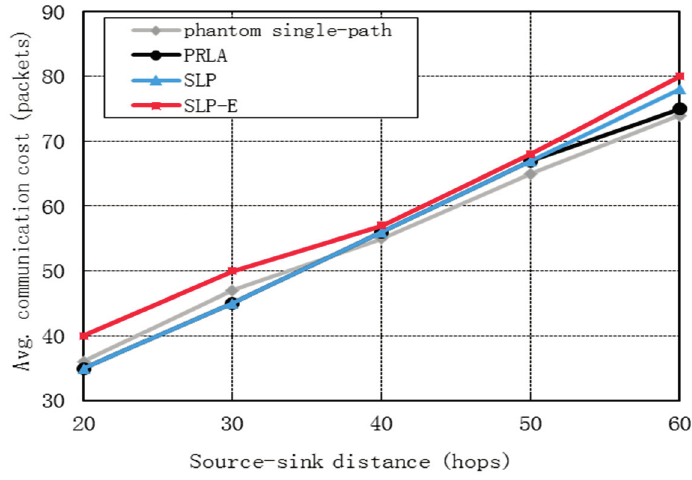
Figure 5. Communication cost vs. source-sink distance .